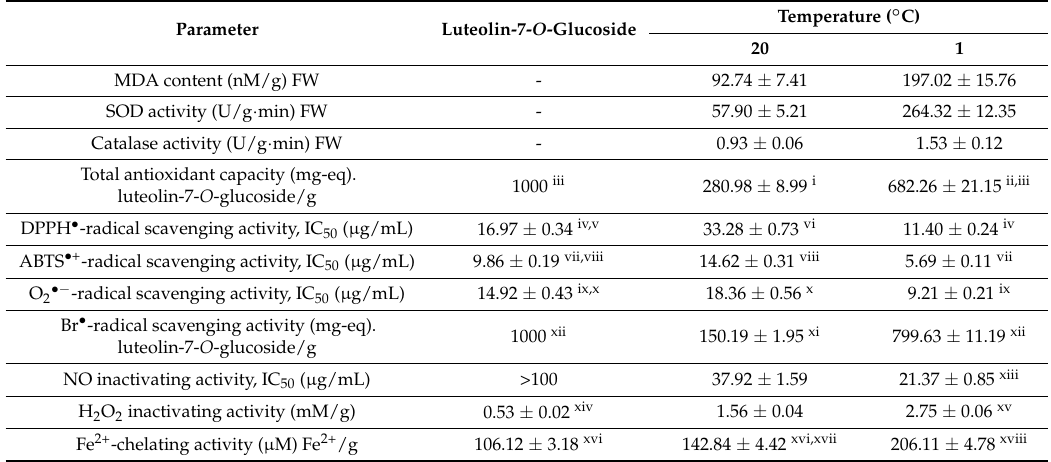
Table 8. Malondialdehyde (MDA) content, superoxide dismutase (SOD) and catalase activities of D. palmatum leaves and antioxidant activity of D. palmatum extracts obtained from the herb grown under different temperatures of cultivation and luteolin-7- O -glucoside as a reference compound a,b .